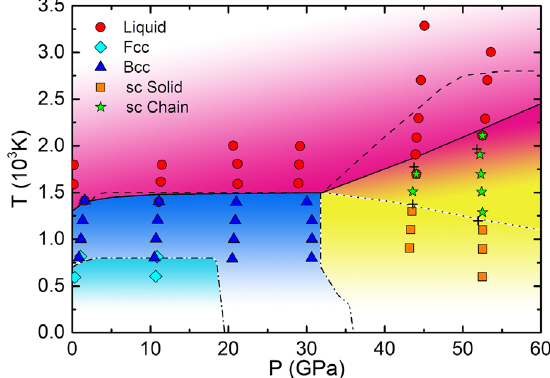
FIG. 6. Phase diagram of Ca based on AIMD simulations up to 3000 K. Orange squares, green stars, and red circles represent solid sc Ca, cooperative diffusion state, and liquid, respectively. Cyan diamonds and blue triangles represent fcc and bcc solid calcium. Black crosses correspond to results of phase boundaries calculated from Gibbs free-energy calculations. The experimental melting lines and phase boundaries (black dashed and dash- dotted lines) were taken from Refs.